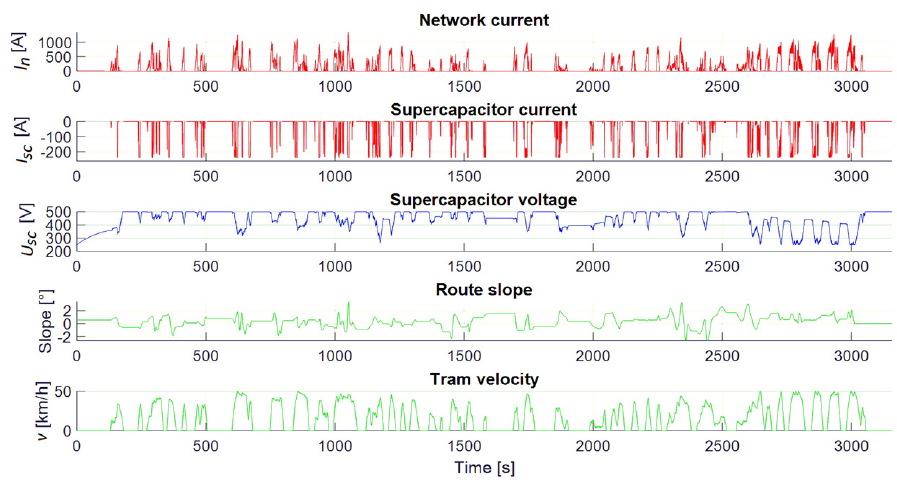
Figure 20. Waveforms during supercapacitor discharging while using the minimum energy algo- rithm.